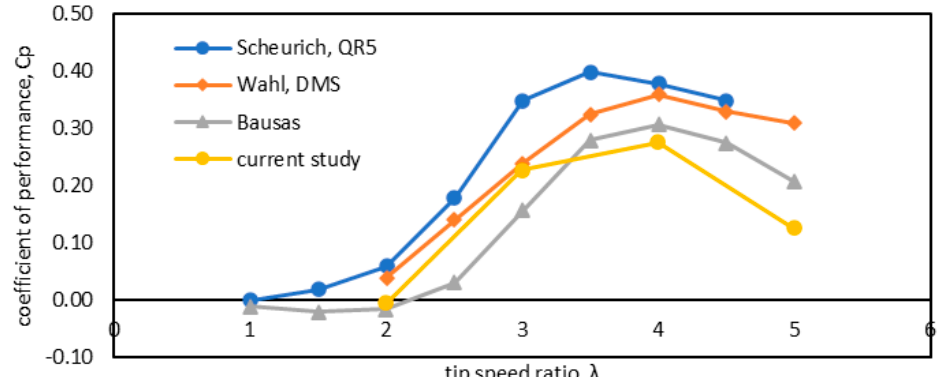
Figure 5. Simulation results superimposed with the results of previously published studies (adapted from [35]).